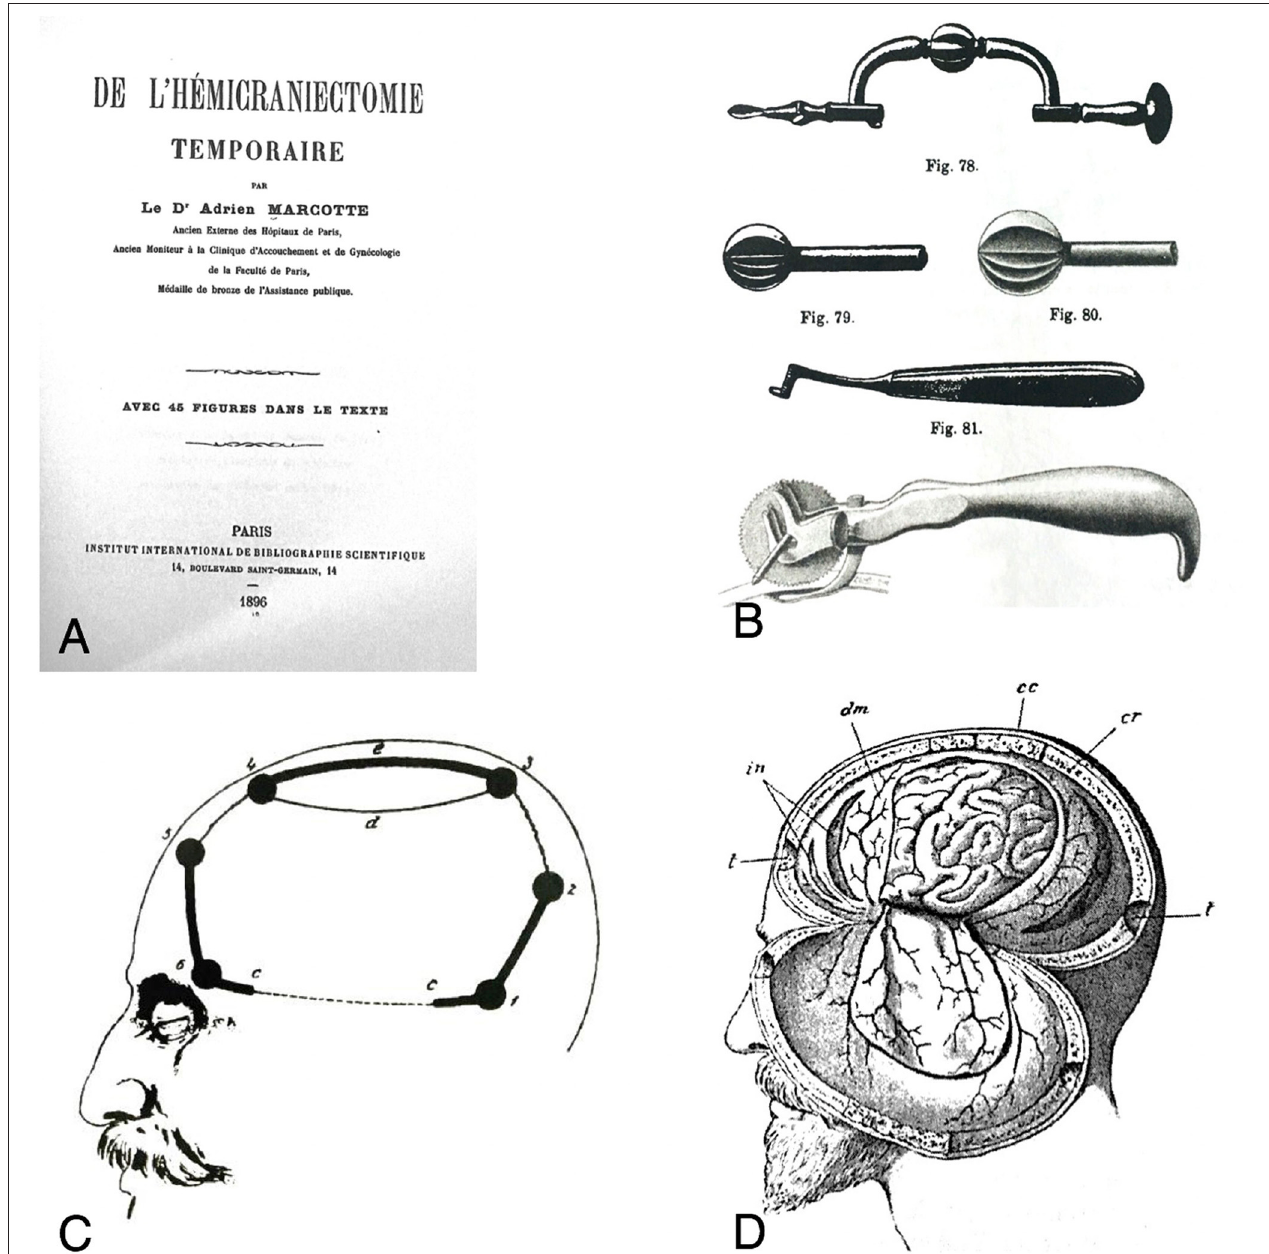
FIGURE 2 | (A) Frontispice of De l’hémicrniectomie temporaire, by Charles Adrien Marcotte. (B) Sample of the surgical instruments used by Doyen. (C) Lines and burr holes showing the extension of the temporary craniectomy. (D) Intradural view after performing temporary hemicraniectomy: the dural flap is usually downward overturned [from Marcotte (16). Figure is in public domain and no permission is required for